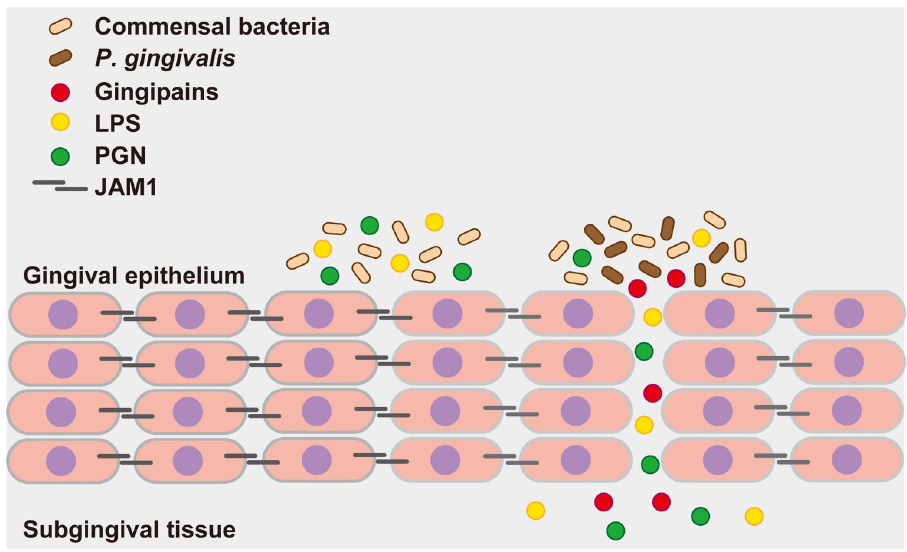
Fig 10. Proposed model of how P . gingivalis gingipains send bacterial virulence factors through the gingival epithelium. P . gingivalis gingipains degrade JAM1, which increases the permeability of gingival epithelium to gingipains and other factors. Subsequently, gingipains are transferred to the deeper epithelium to further degrade JAM1, which allows LPS and PGN to penetrate the gingival epithelium and reach subepithelial tissues. Finally, gingipains, LPS, and PGN induce inflammation in gingival